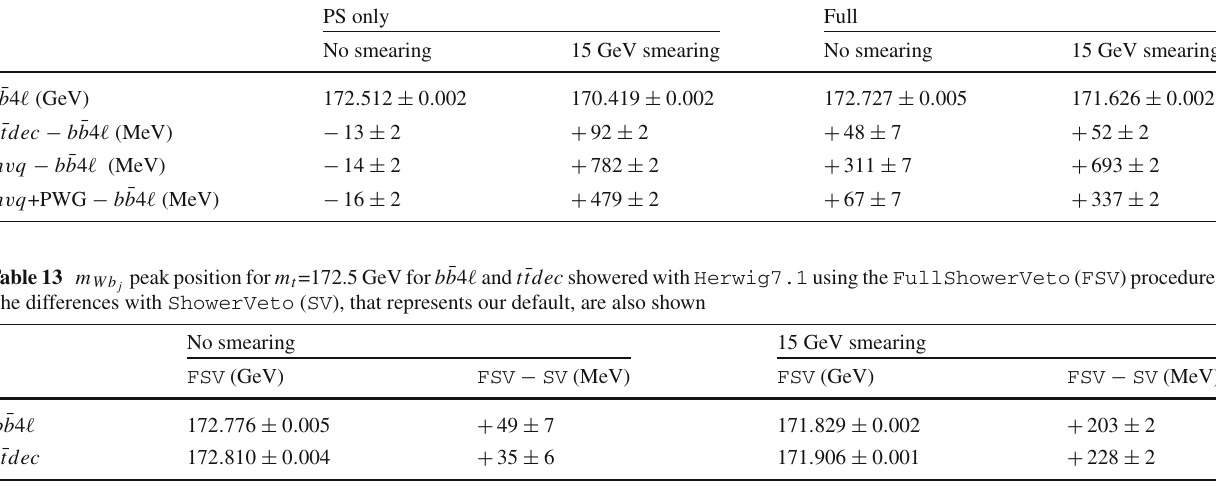
Table 14 m Wb peak position for m t =172.5 GeV obtained with the b ¯ b 4 (cid:4) and t ¯ tdec generators showered with Herwig7.1 , with the settings of j Eq. (18) (labelled as TS). The differences with the default results are also shown No smearing 15 GeV